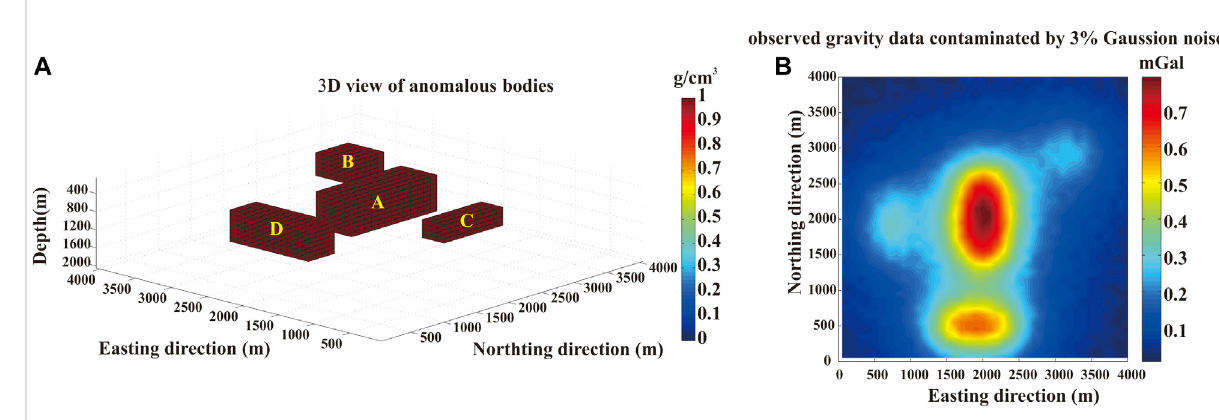
FIGURE 1 (A) 3Dviewoftheanomalousbodydensitydistributions; (B) observedgravitydatacontaminatedbynoisewithinthe3%ofthemaximumvalueof the gravity data.